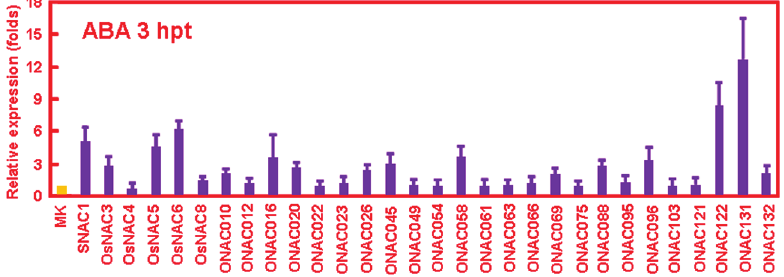
Figure 2. Differential expressions of 30 selected ONAC genes in response to